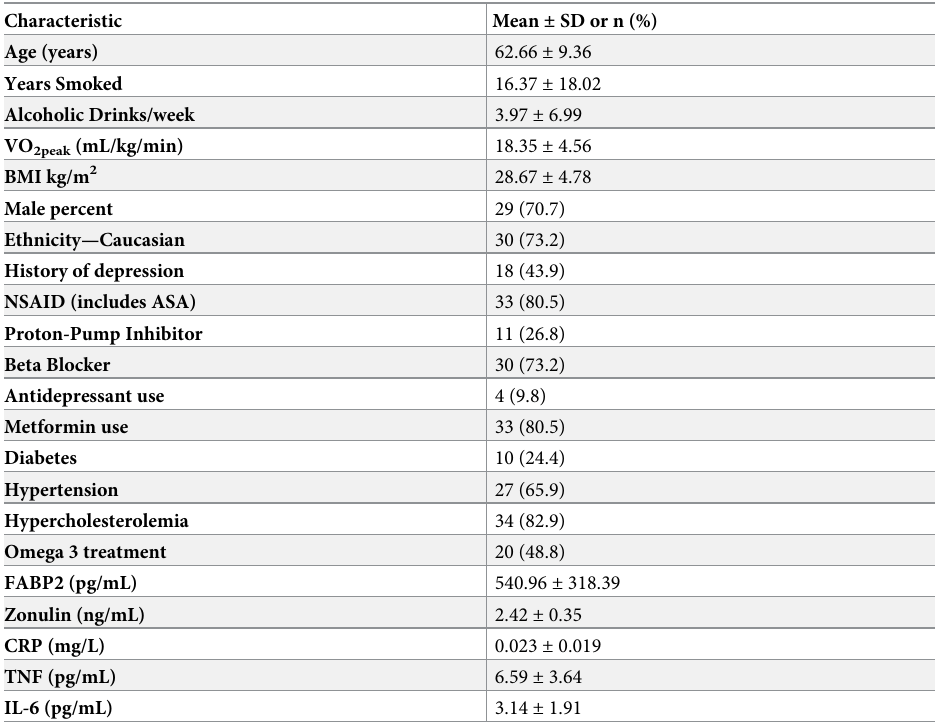
Table 1. Baseline characteristics of all